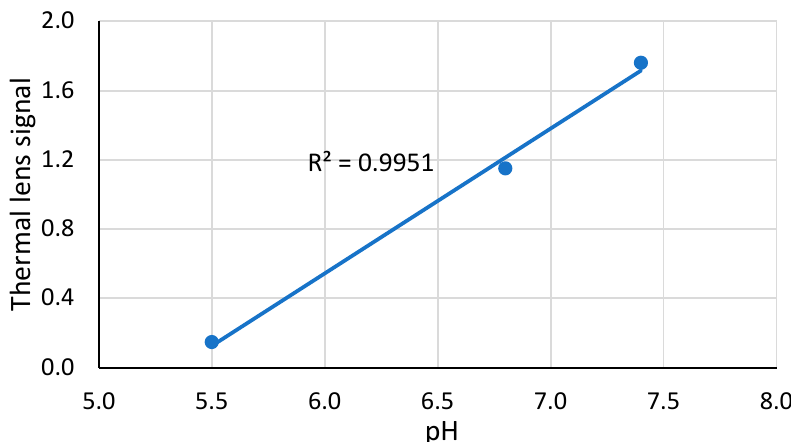
Figure 5. The dependence of the thermal lens signal of ferricytochrome c , 4.0 µM, after 4 h of preparation on pH; excitation, 514.5 nm, 40 mW.